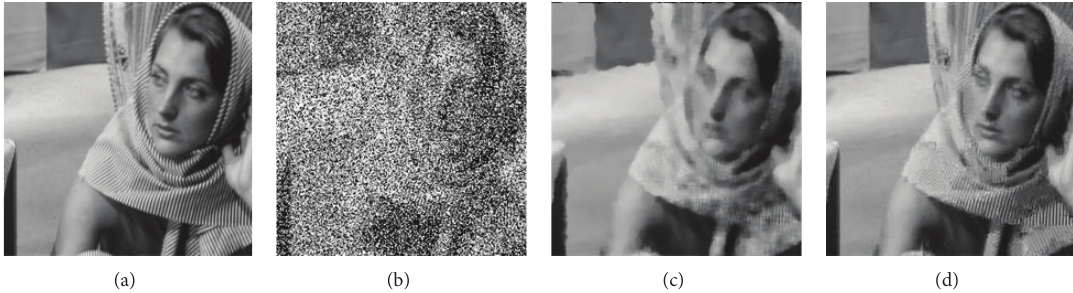
Figure 1: Restored image from 50% salt and pepper noise using median filtering and PANO. (a) Noise-free image, (b) noisy image with 50% salt and pepper noise, and (c) and (d) restored images using median filtering and PANO.